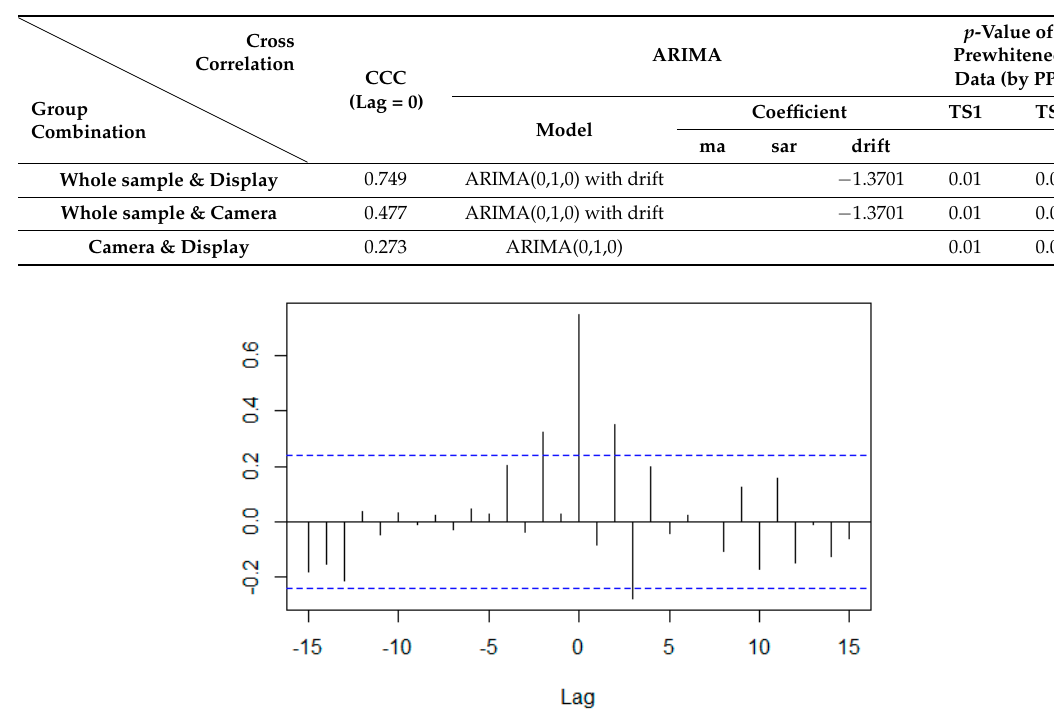
Figure 10. Cross-correlation coefficient between the average CAR of the whole sample group and the average CAR of the display group for Evaluation period: Jan 2010–Dec 2011, Event period: Jan 2013–Jul 2018.